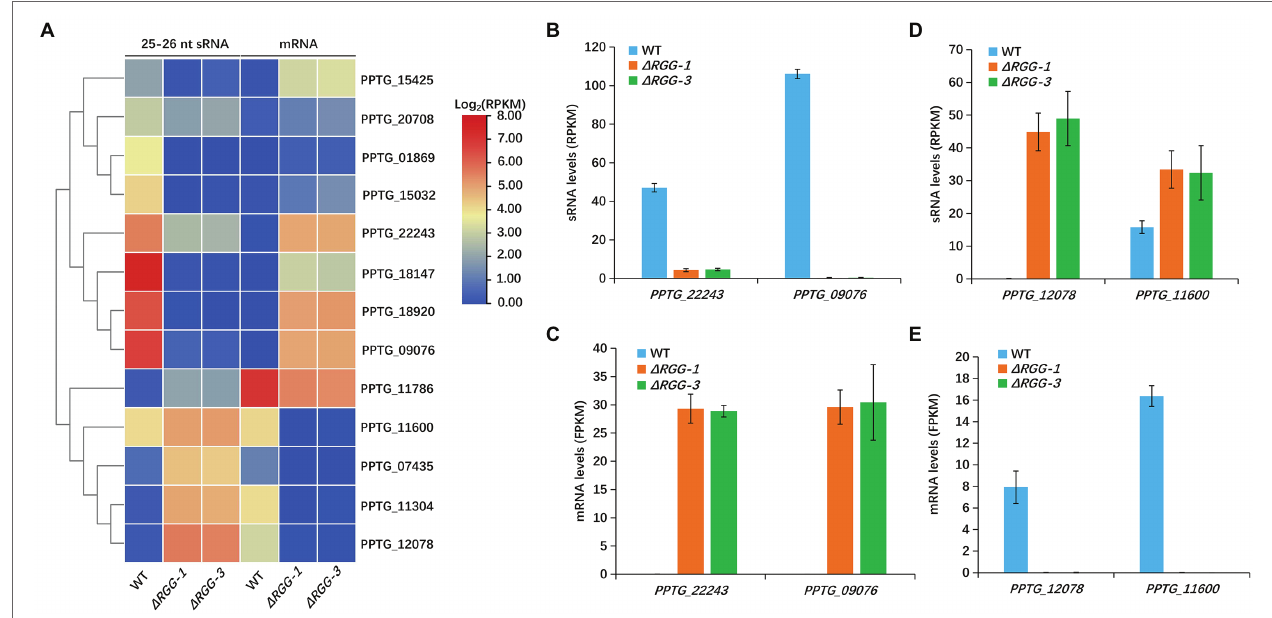
FIGURE 4 | The changed 25–26 nt sRNA accumulation in mutants PpAGO3 Δ RGG1 and PpAGO3 Δ RGG3 was negatively correlated with expression of the corresponding effector genes. (A) The heatmap for 13 effector genes with which 25–26 nt sRNA and mRNA levels were negatively correlated in mutants PpAGO3 Δ RGG1 and PpAGO3 Δ RGG3 compared to the wild-type. The color represents the transformation value of log 2 (RPKM) for sRNA and log 2 (FPKM) for mRNA. (B–E) The 25–26 nt sRNA and mRNA levels of four representative effector genes, PPTG_22243 , PPTG_09076 , PPTG_12078 , and PPTG_11600 . The 25–26 nt sRNA levels were significantly reduced for PPTG_22243 and PPTG_09076 (B) and the mRNA levels were increased obviously (C) in mutants PpAGO3 Δ RGG1 and PpAGO3 Δ RGG3 . On the contrary, the 25–26 nt sRNA levels were increased (D) but the mRNA levels were reduced (E) for PPTG_12078 and PPTG_11600